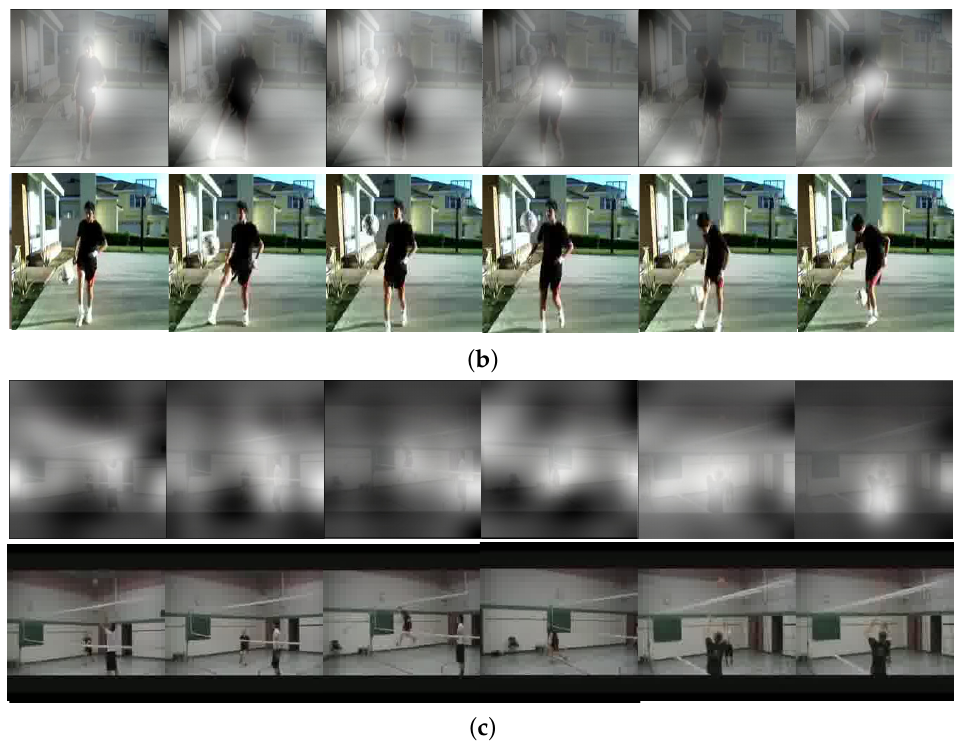
Figure 4. The illustration of some correct examples: ( a ) horse-riding example; ( b ) soccer example; and ( c ) volleyball example.